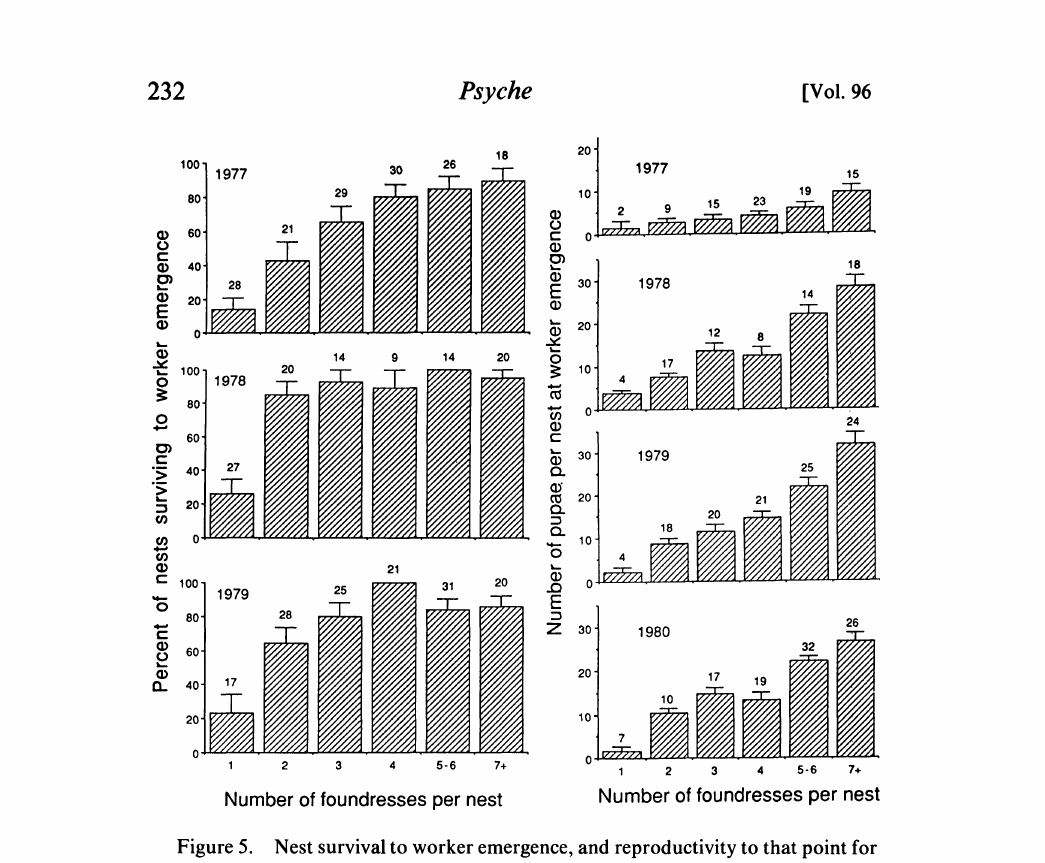
Figure 5. Nest survival to worker emergence, and reproductivity to that point for surviving nests measured in pupae as a function of numbers of foundresses. The bar represents the mean, the line is the standard error, and the number over the standard error is the number of nests examined. Pardi 1947), P. carolina in Kirkwood, Missouri (6.0 +__ 7.4,